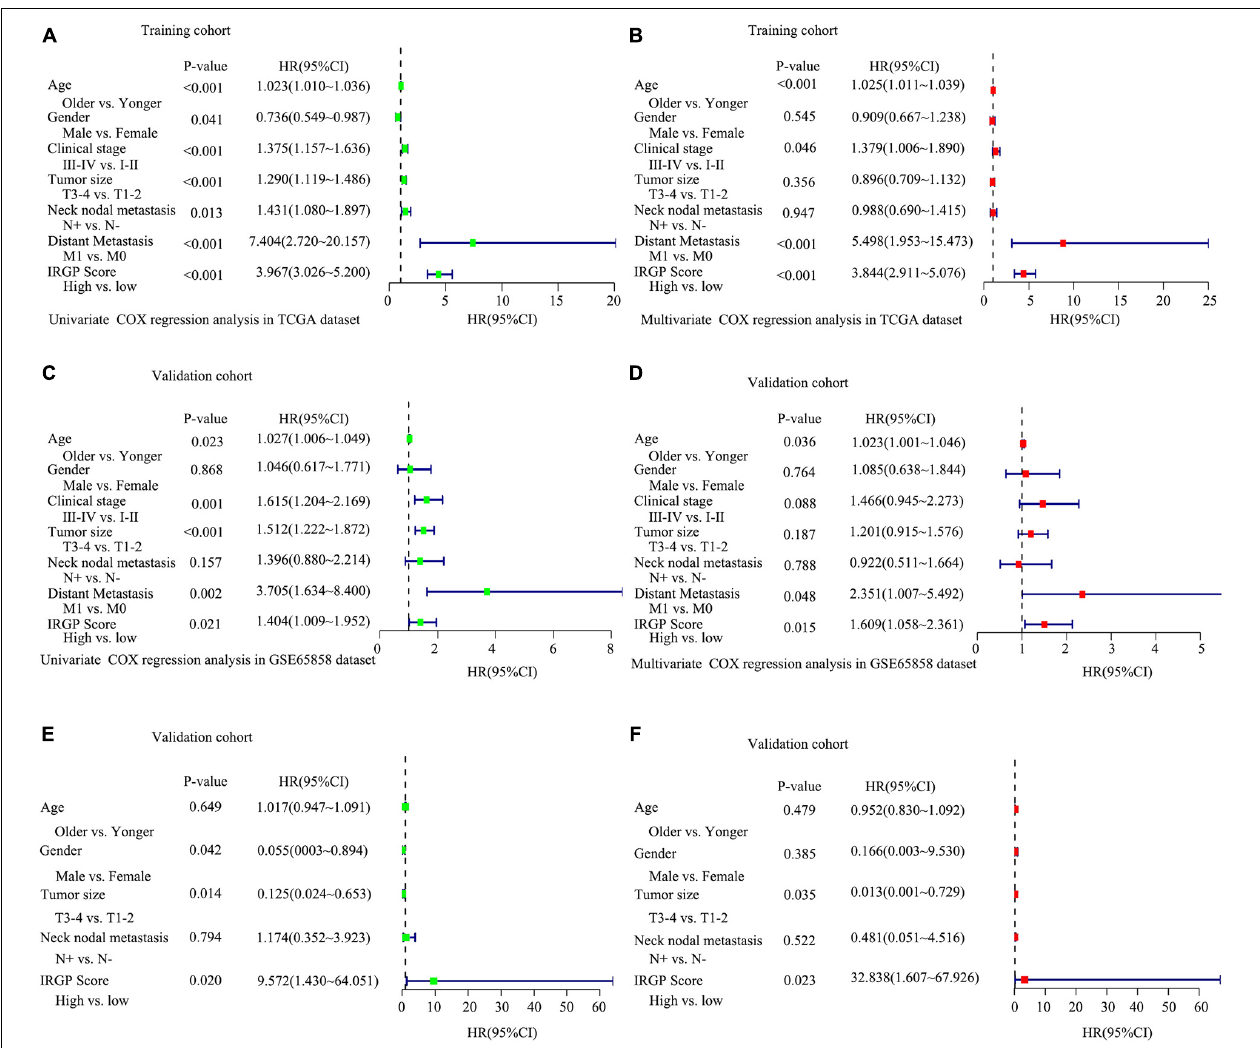
FIGURE 3 | Explored and validation of independent clinical prognostic factors related to the signature of IRGPs in HNSCC. Univariate analysis and multivariate analysis were used to explored independent clinical prognostic factors in the TCGA dataset (A,B) , validated in GSE65858 dataset (C,D) and GSE2379 dataset (E,F)